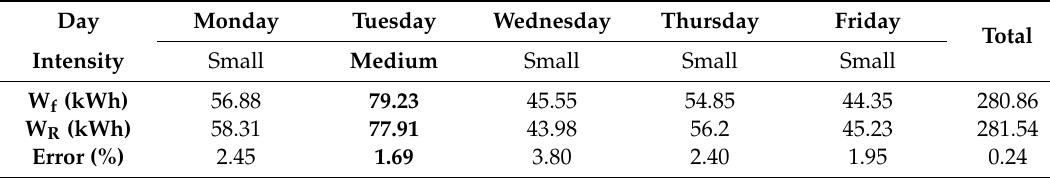
Table 9. The obtained results using the proposed